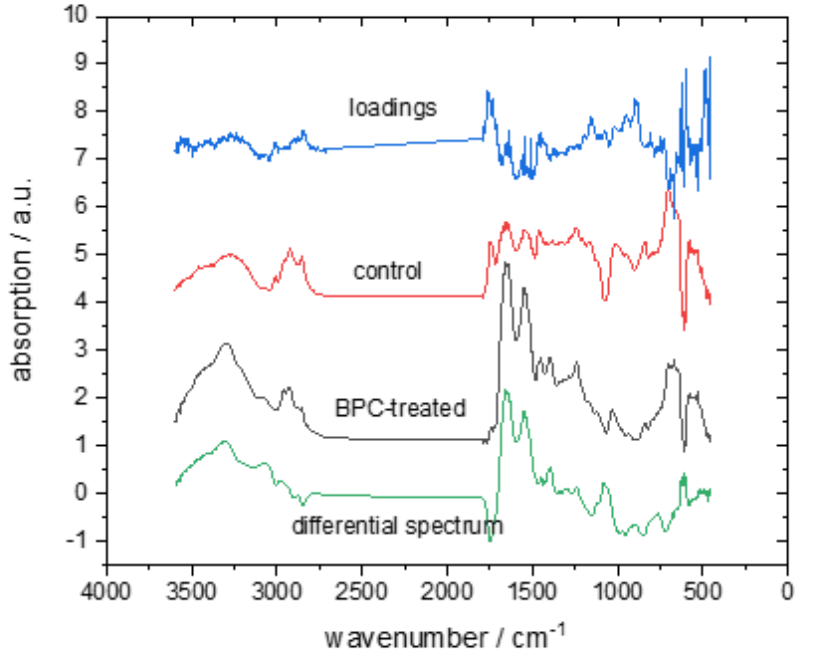
Figure 2. The average FTIR spectra of the control group (red line) and BPC 157-treated (black line) group were obtained in the spectral range between 4000 and 500 cm − 1 . The differential spectrum of the average BPC 157-treated spectrum minus the control spectrum (grey line) and corresponding PC1 loadings (blue line) are shown.